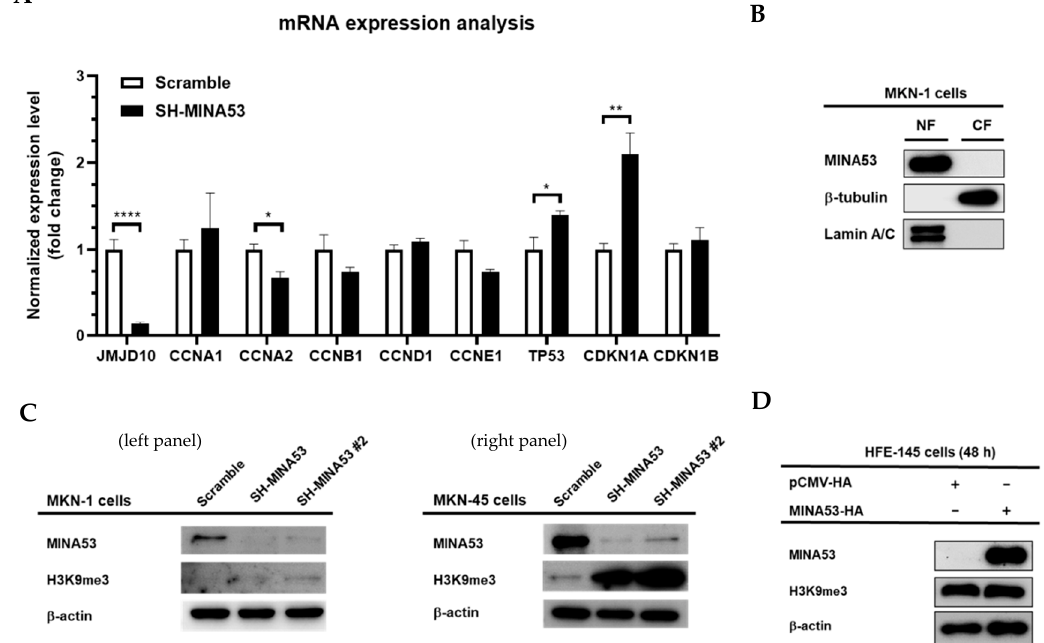
Figure 5. Molecular signature of MINA53 in gastric cancer cell lines. ( A ) mRNA expression analysis of JMJD10 in MINA53-silenced MKN-1 cells. ( B ) MINA53 mainly localized in the nuclear fraction; Lamin A / C and β -tubulin were used as loading controls for nuclear and cytosolic fractions, respectively. ( C ) Analysis of H3K9me3 level in MINA53-silenced MKN-1 cells (left panel) and MKN-45 cells (right panel). ( D ) Overexpression of MINA53 in human gastric normal cell lines (HFE-145) does not affect the H3K9me3 level. The whole Western blot images please find in Figure S1.